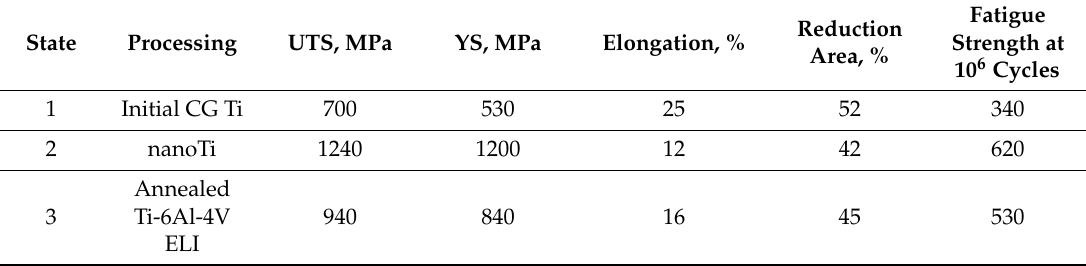
Table 1. Mechanical properties of coarse-grained (CG) and nanostructured CP Grade 4 Ti. Annealed Ti-6Al-4V ELI (extra low interstitials) alloy for comparison.